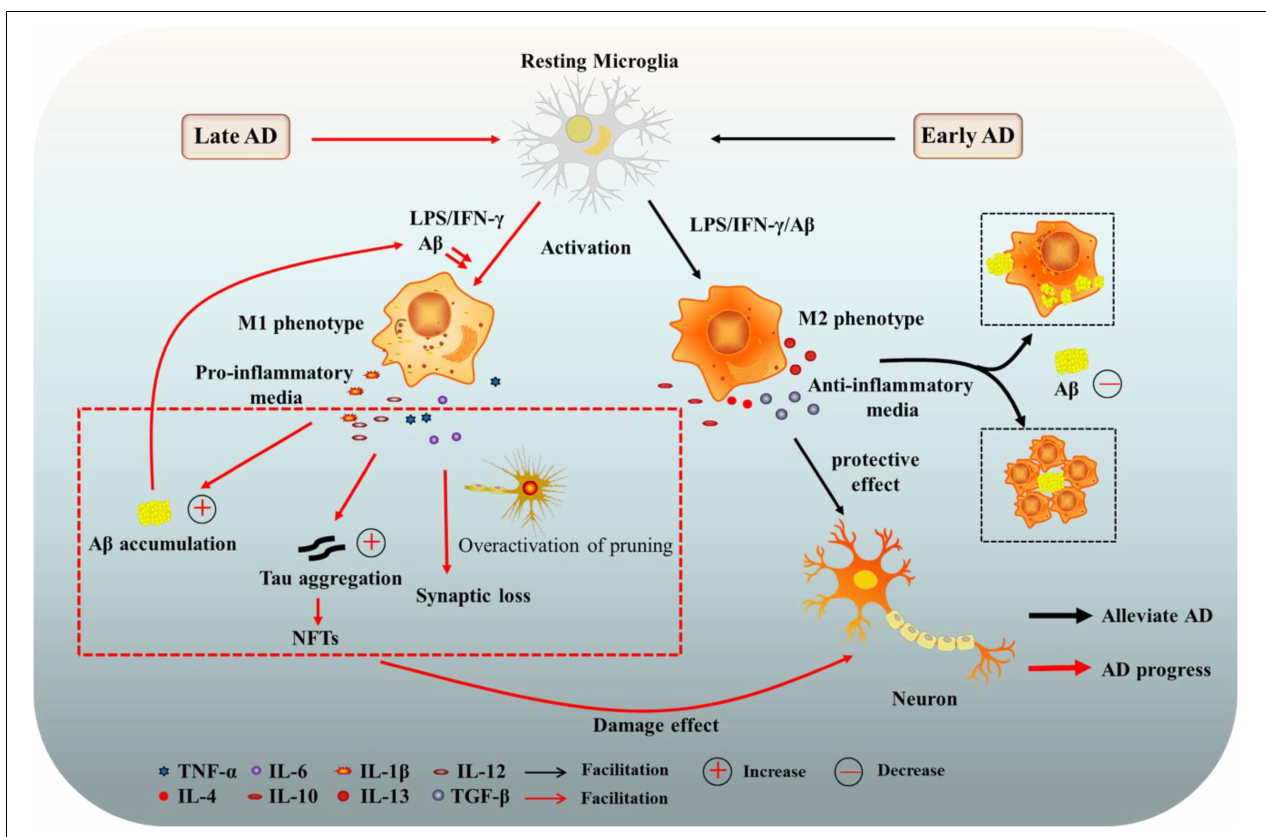
FIGURE 1 | The role of microglia in Alzheimer’s disease (AD). Microglia can have beneficial or harmful effects on AD. In the early stage of AD, the activation state of microglia is mainly a protective phenotype (M2), secreting anti-inflammatory mediators and neurotrophic factors, and clearing or isolating A β and Tau proteins, contributing to the protection of neurons. In late AD, microglia tend to be activated as a harmful phenotype (M1), enhancing the release of pro-inflammatory factors, which damage neurons and promote the progression of AD. AD, Alzheimer’s disease; A β , amyloid beta-protein; NFTs, neurofibrillary tangles; LPS, lipopolysaccharide; TGF- β , transforming growth factor- β ; IFN- γ , interferon γ ; TNF- α , tumor necrosis factor- α ; IL-6,